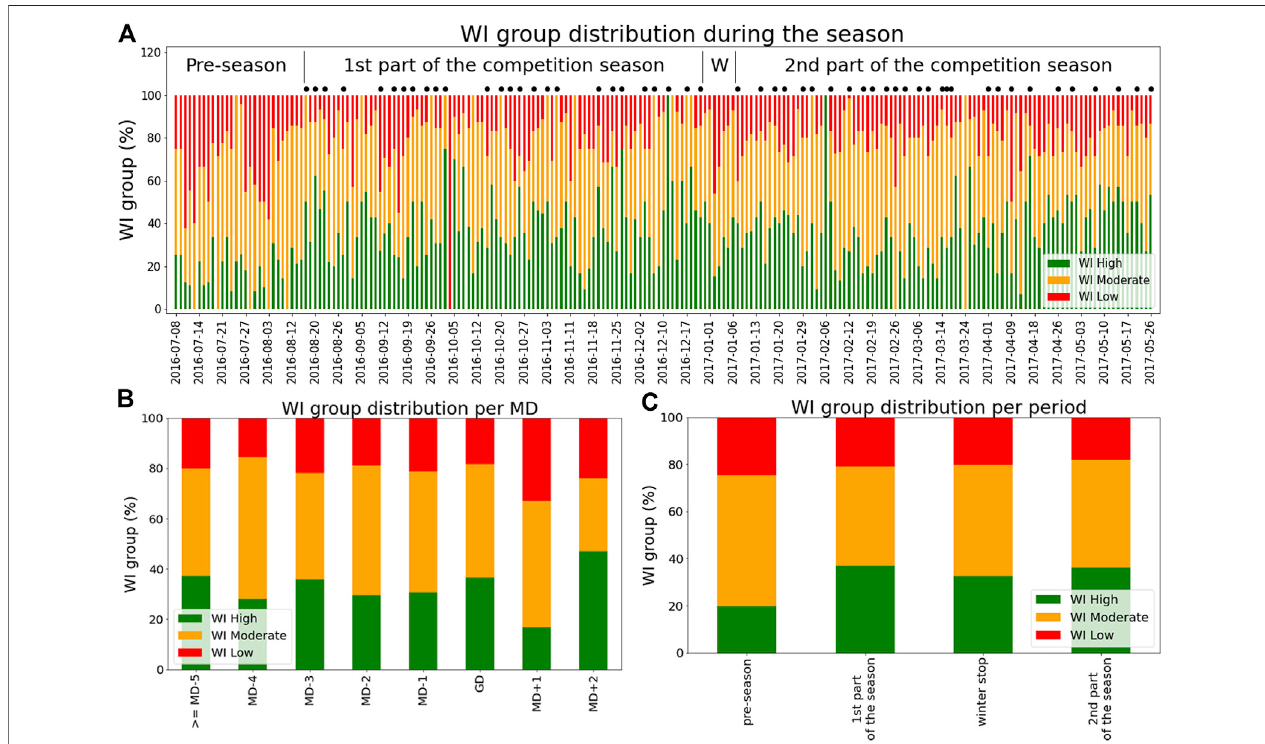
FIGURE2 |(A) Distributionof WIday byday as theseason wentby. The black dots refer tothe Game Day (GD). Moreover, W refers towinter stop. (B) Distribution of WI in accordance with the Match Day (MD). The values refer to the day when the WI are recorded. For example, the WIs reported in Game Day (GD) refer to the WI recorded before the start of the match. (C) Distribution of WI in accordance with the periods of the season.